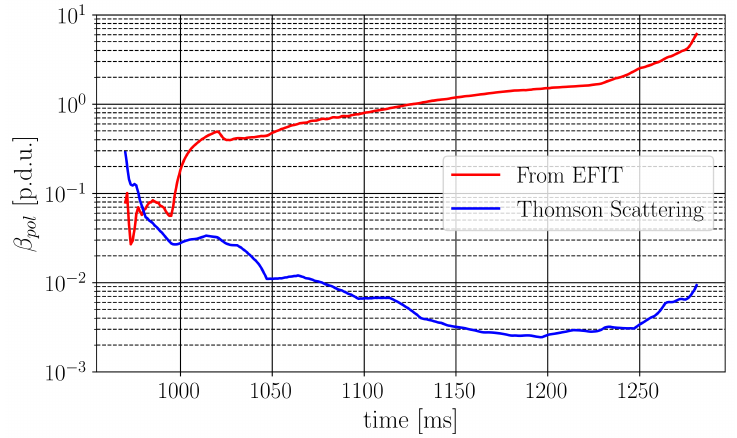
Figure 1. Poloidal beta β pol estimated by EFIT (red) and from Thomson Scattering (blue) for discharge #7298. (cid:68) (cid:69) − p pl The P RE = (cid:104) p tot (cid:105) is calculated as an average from obtained P RE values V V